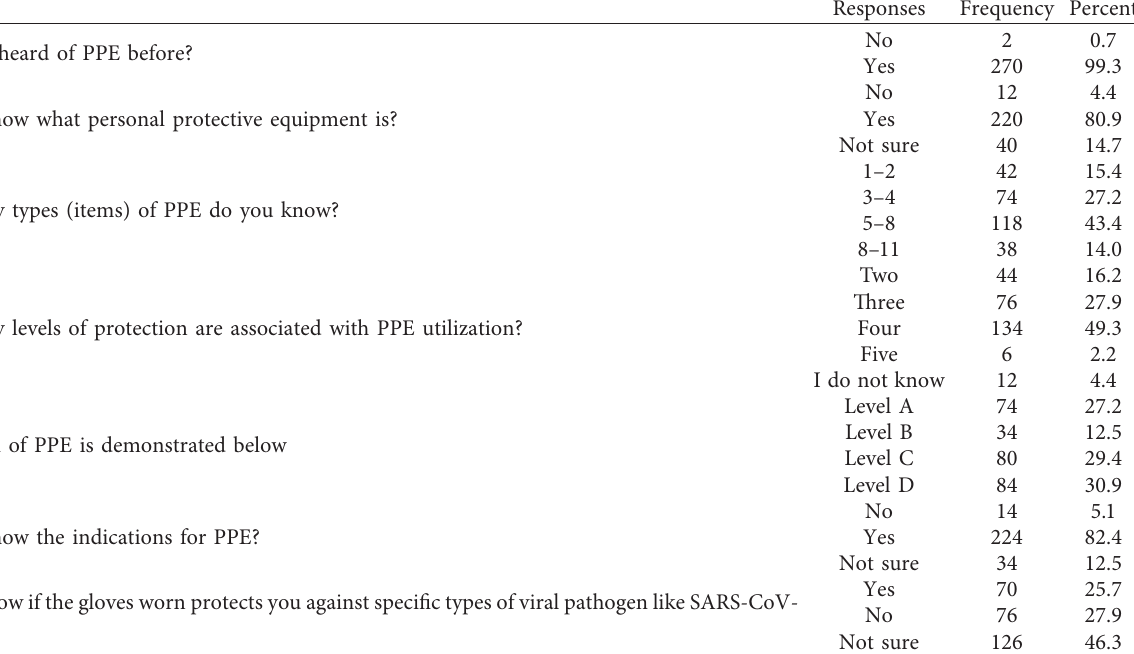
Table 3: General knowledge of respondents on PPE.